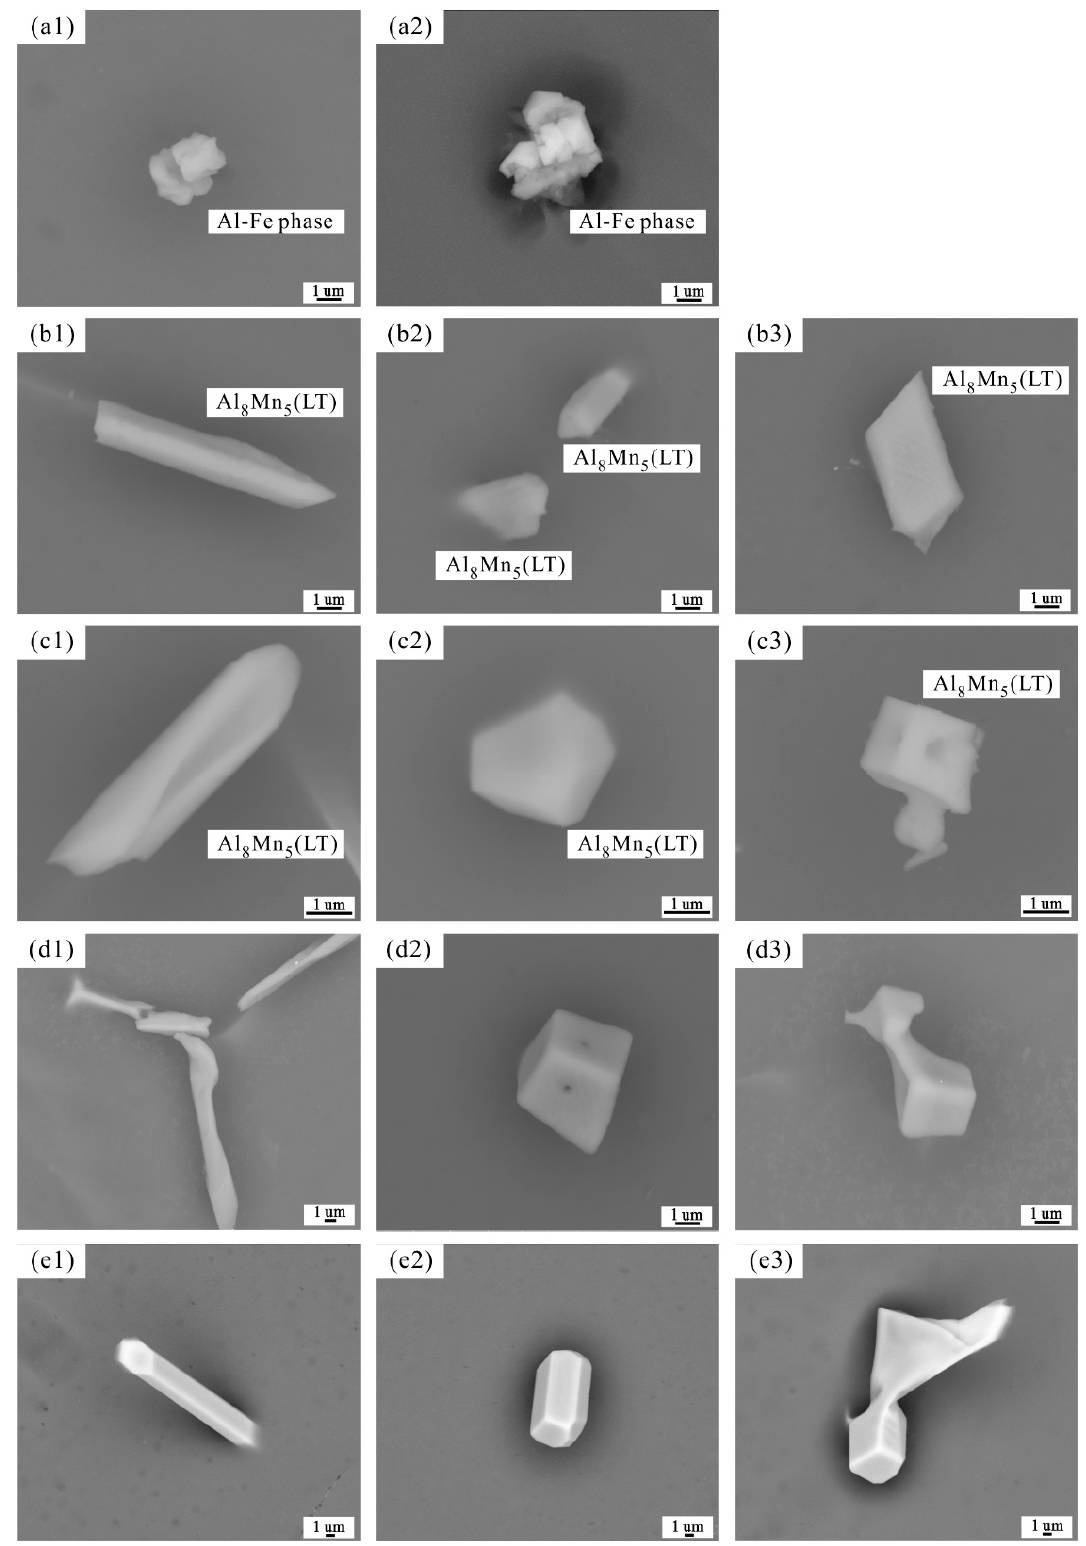
Figure 6. BSE images of typical particles in the etched Mg-3Al- x Mn alloys by SEM: ( a ) Mg-3Al alloy,